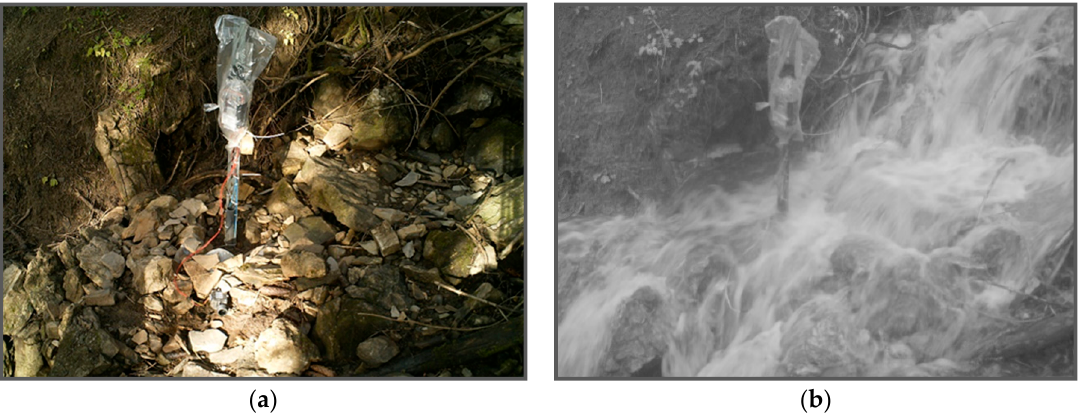
Figure 12. Two examples of time-lapse photos of one of the multi-sensor monitoring systems (2016 field season): ( a ) dry channel (state data: no water and no flow) and ( b ) flowing water (state data: water and flow).